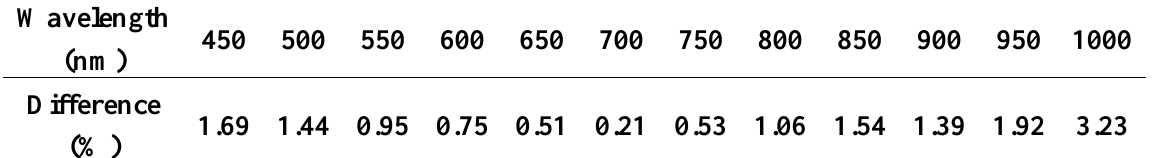
extracted with CLabSpeG and EGO ref